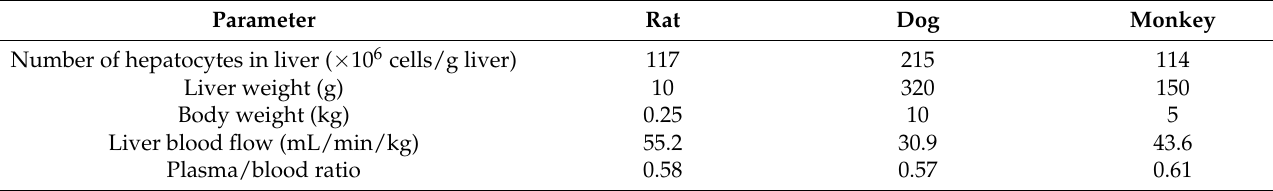
Table 1. Physiological parameters for calculation of clearance values